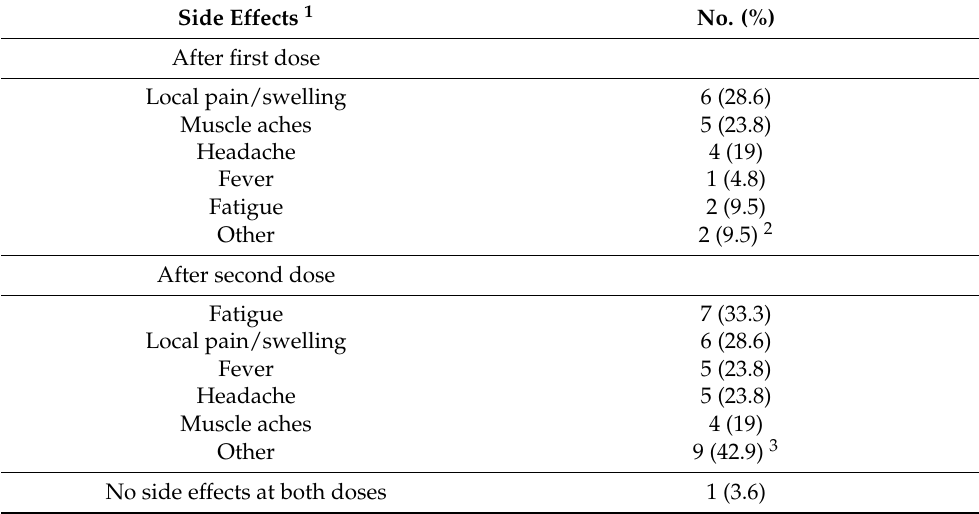
Table 2. Side effects after administration of the mRNA-based COVID-19 vaccine